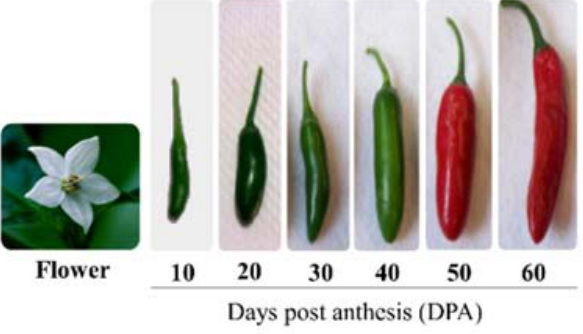
Figure 1. Ripening process of Capsicum annuum cv. ‘Tampiqueño 74’ fruits.